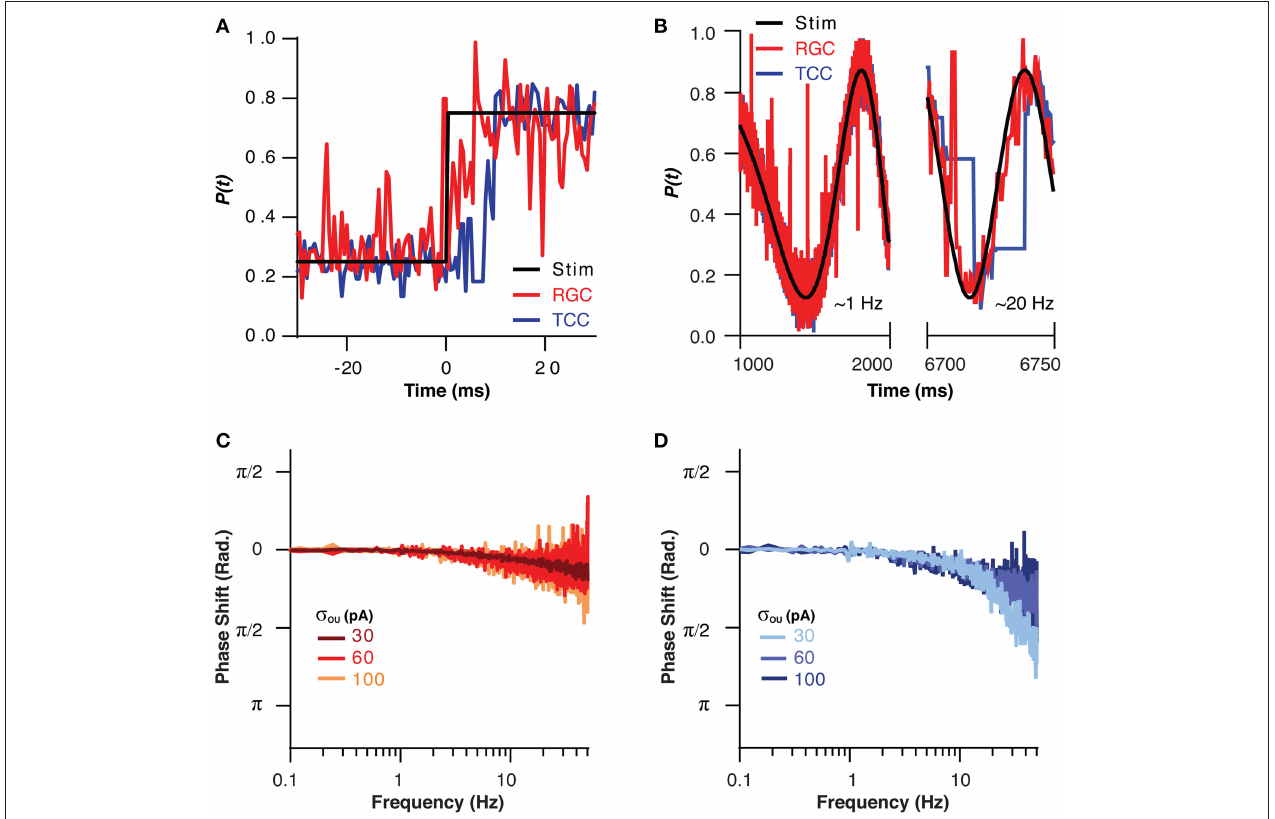
FIGURE 4 | The filtering effect of the thalamic layer comes at the cost of response rate. (A) The position encoded by the RGC and TCC layers in response to a step change in the position of the stimuli, note the response of the TCC layer is significantly delayed relative to the response of the RGC layer. (B) Two sections of the response of the RGC and TCC layers to a sinusoidal input of increasing spatial frequency ( σ ou = 0 .03). (C) The phase of the RGC layer response with respect to the stimuli, showing the minimal phase shift and general independence from the magnitude of retinal noise. (D) The phase of the TCC response with respect to the stimuli, showing the large phase shift than that seen in the RGC layer, and the effect that increasing retinal noise decreases the phase shift seen in the TCC